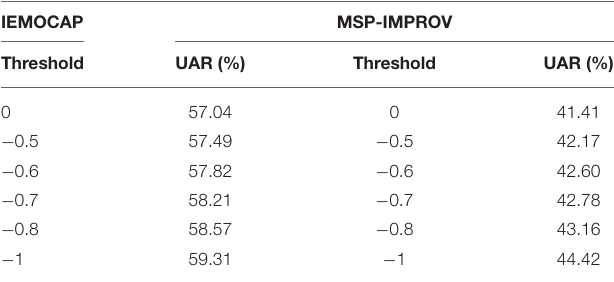
TABLE 4 | The results of different threshold on cosine similarity in both IEMOCAP and MSP-IMPROV databases.